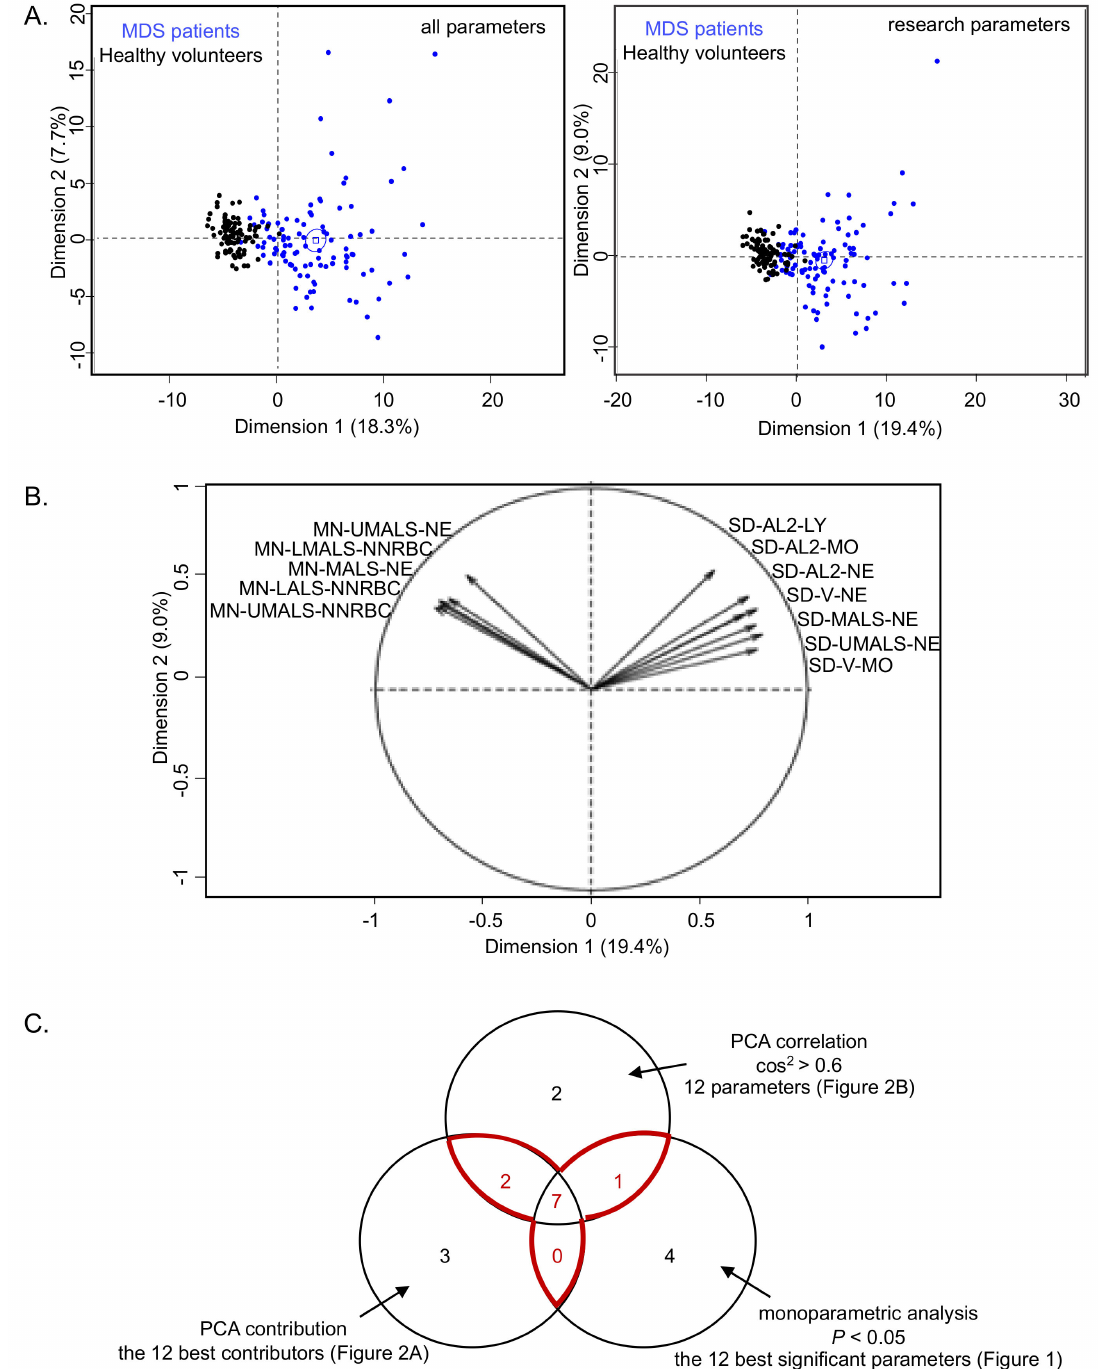
Figure 2. Principal component analyses (PCA) of MDS patients (blue) vs. healthy volunteers (black). ( A ) Individual graphs of PCA with all 126 parameters of the DxH 800 hematology analyzer (left panel) or with the 103 “research parameters” (right panel). Both PCAs show a satisfying segregation between the two groups. ( B ) Variables graph. Parameters with cos 2 > 0.6 are illustrated. A high cos 2 indicates a good representation of the parameter on PCA. The means of five CPD parameters of neutrophils and leukocytes are correlated negatively to the first axis. Conversely, standard deviation of 7 CPD parameters are correlated positively to the first axis. All parameters are related to leukocyte (NNRBC) and neutrophil characteristics, related to decreased granularity and cellular heterogeneity. ( C ) Venn diagram. Ten parameters of interest are identified by comparing MDS patients and healthy volunteers with monoparametric analysis, PCA contribution, and PCA